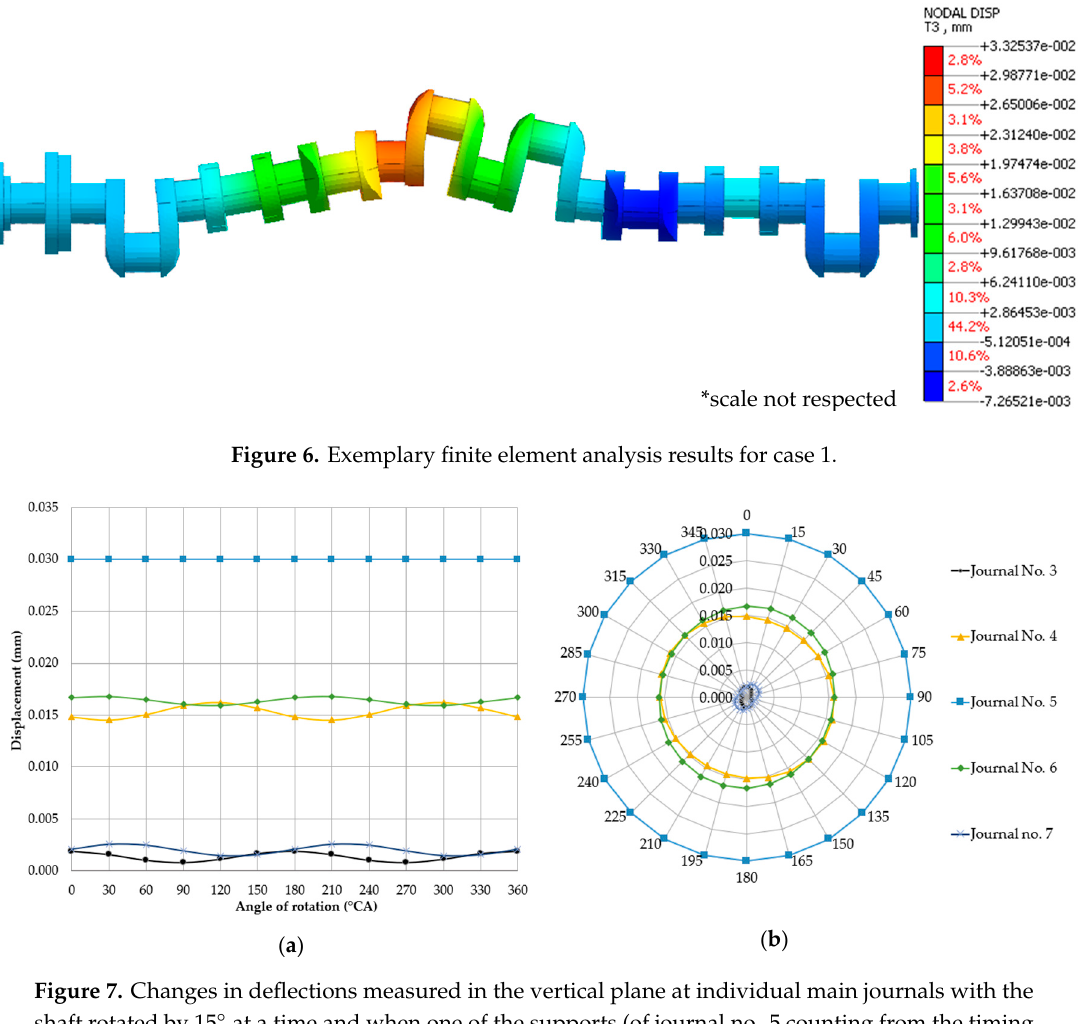
the shaft rotation angle was changed by 90° and one of the supports (of journal no. 5 counting from the timing gear end) was offset upwards by 0.03 mm relative to the others.